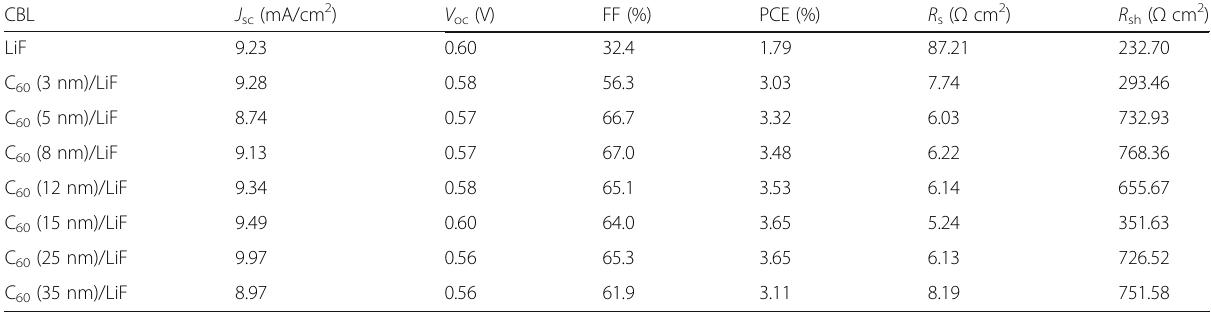
Table 1 Photovoltaic parameters for the P3HT:PCBM-based PSCs with and without different thicknesses of C 60 inserted between the active layer and 5-nm-thick LiF layer